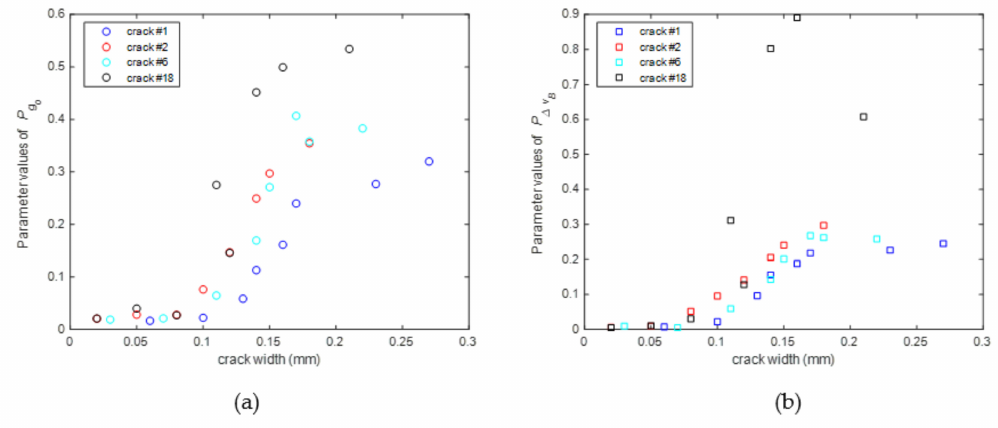
Figure 25. Relations between parameters P g